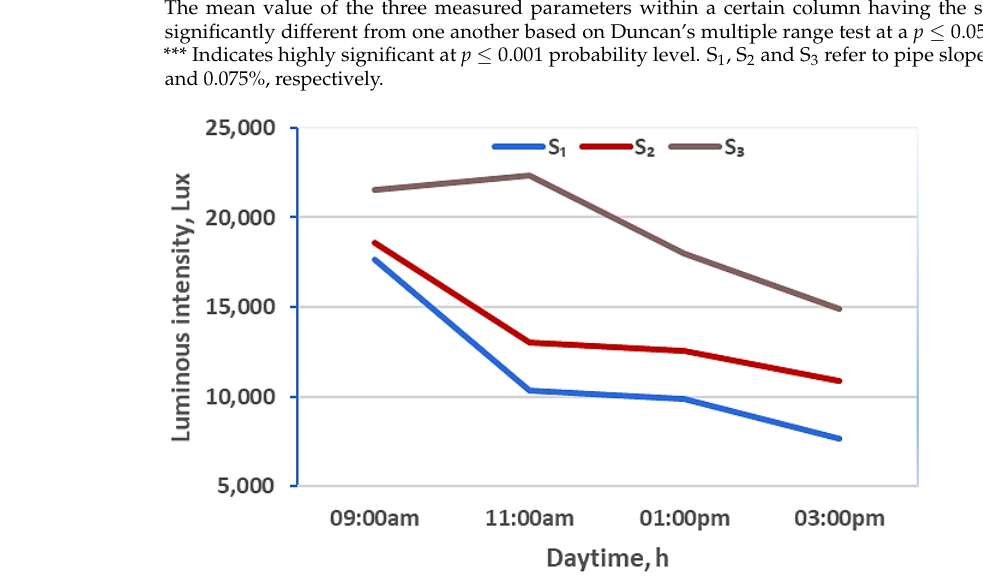
Figure 1. Luminous intensity recorded at different times throughout the day with different